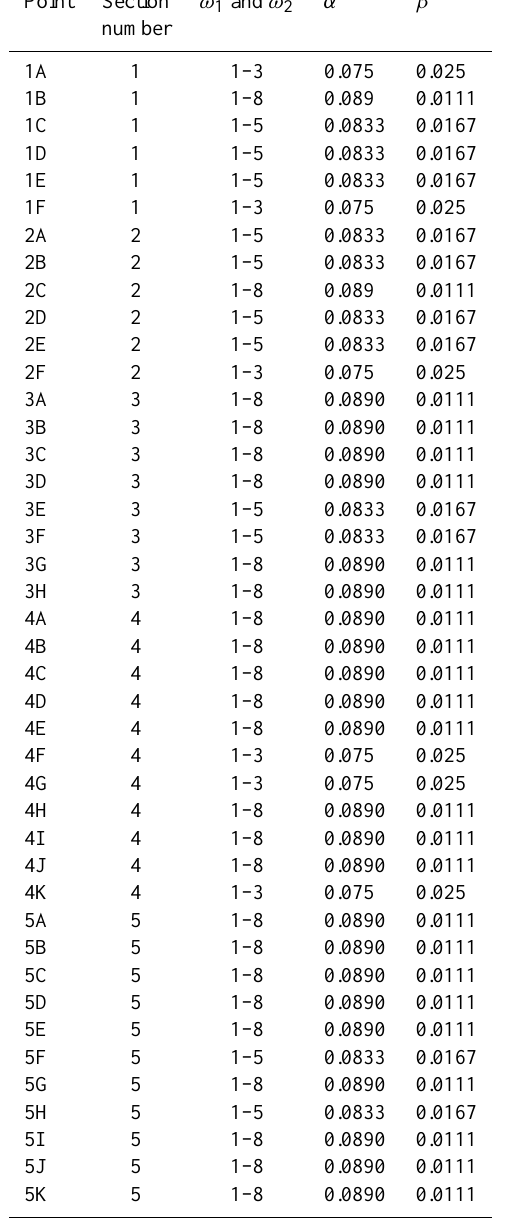
Table 4. α and β values at selected points for all sections.